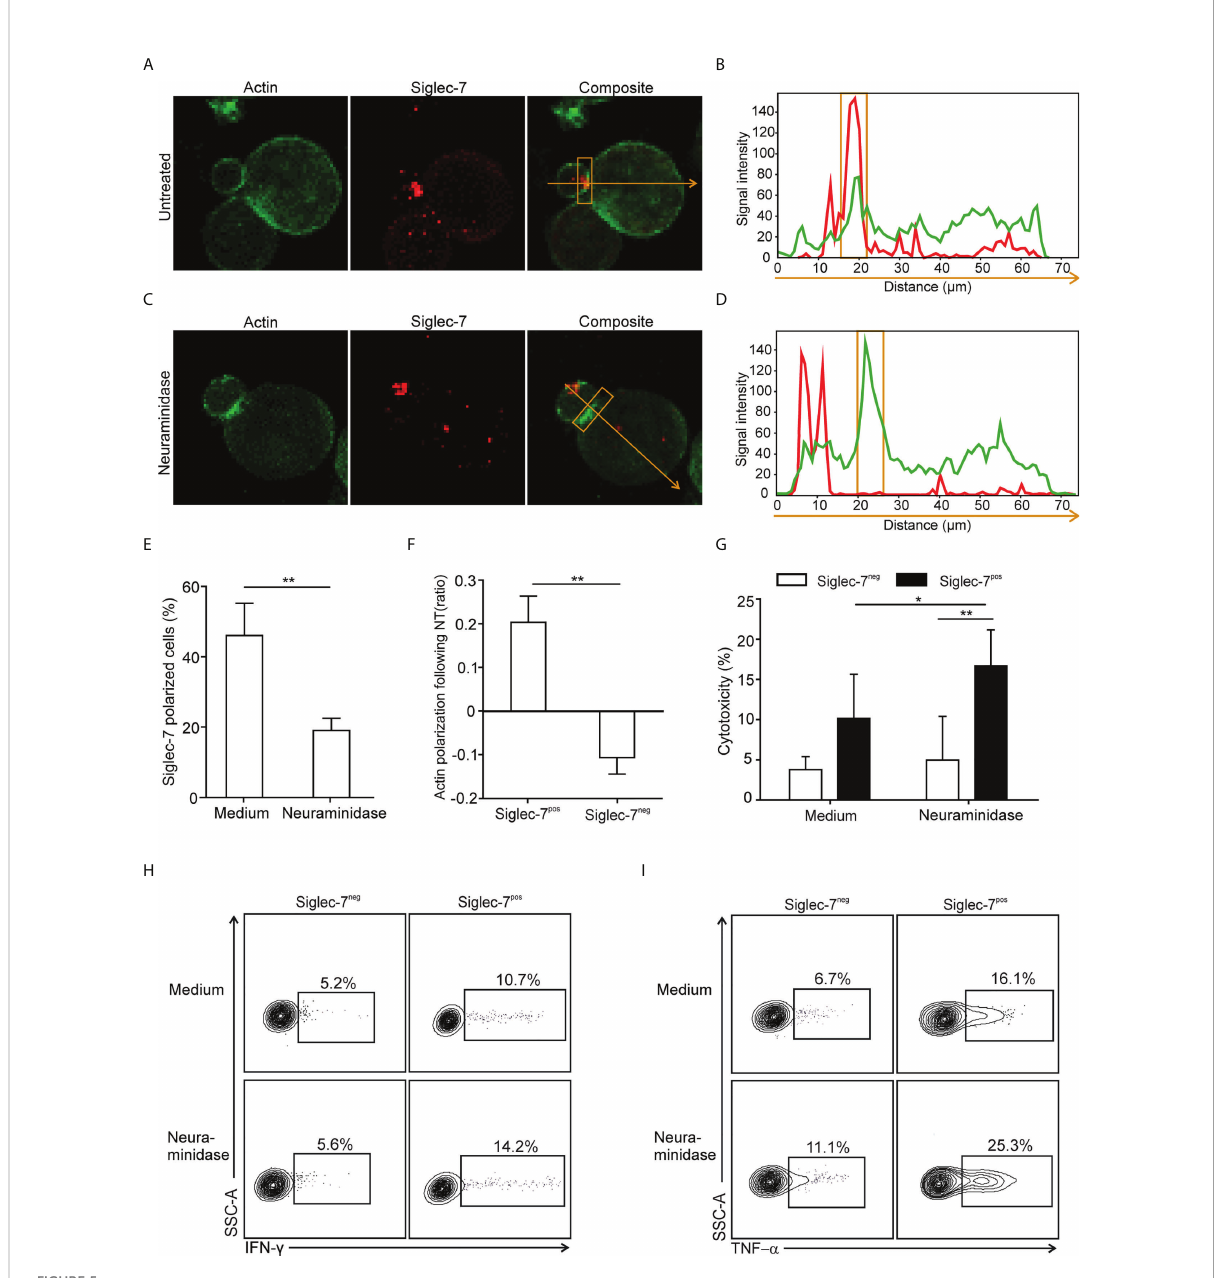
FIGURE 5 Polarization of Siglec-7 and inhibition of Siglec-7 + CD8+ T cells induced by sialoglycans on tumor cells. (A – F) Confocal immuno fl uorescence microscopy analysis of immunological synapse (IS) formation between redirected CD8+ T cell subsets and a CD3 mAb-loaded P815 tumor cells in absence or presence of target cell neuraminidase treatment (NT). Representative images (A, C) and corresponding fl uorescence pro fi les plotted along the indicated trajectory (B, D) . Quanti fi cation of Siglec-7 polarization on T cells towards the IS (E) , or actin staining intensity at the synapse (F) , compared with the opposite side of the same T cell. (G – I) Effects of neuraminidase pre-treatment of P815 target cells on redirected cytotoxicity (G) and intracellular IFN- g (H) or TNF − a (I) production 4 h after target cell loading with a CD3 mAb (n=5). (A – F) analysis of at least 40 conjugates from three independent experiments with cells from at least three donors. Statistical analyses were performed by paired t test (E – G) or one-way ANOVA followed by Bonferroni posttest (H, I) . *P < 0.05; **P < 0.01. Error bars,